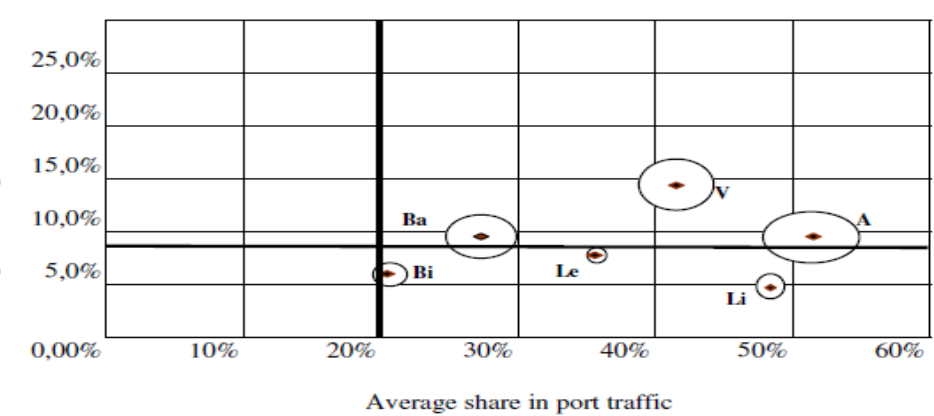
Figure 10 : Containers vs seaport traffic